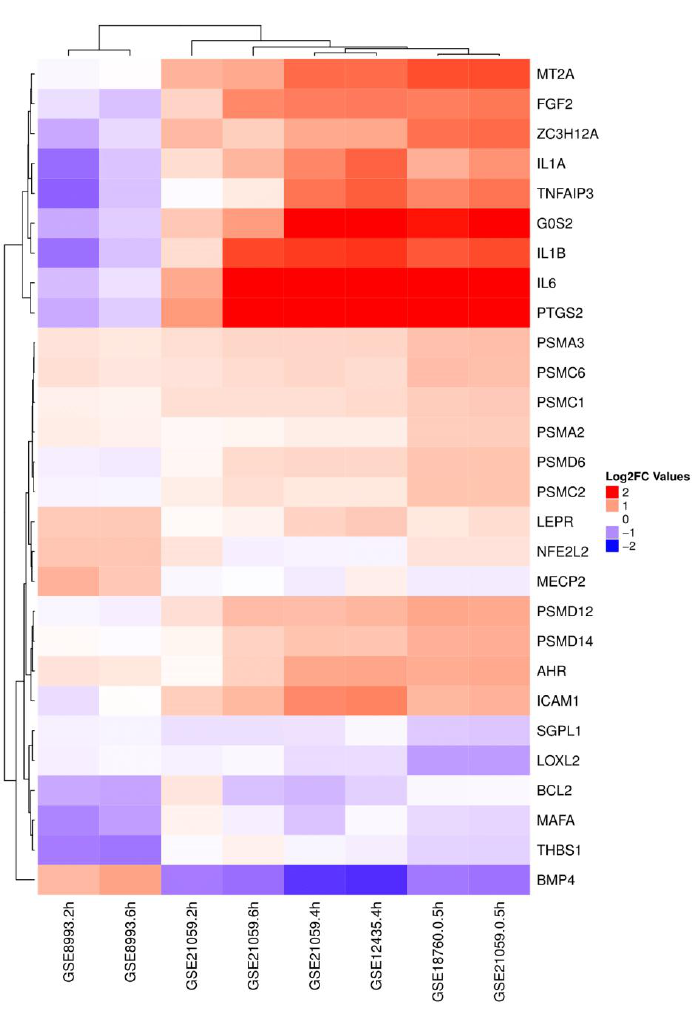
Figure 2. Heat map of the RIBE gene signature regarding the GSE12435*, GSE18760*, GSE21059*, and GSE8993 + datasets for the comparisons of bystander vs. control samples (GSEs with an asterisk highlight α -particles IR whereas the one marked with the plus symbol underlines carbon-ion IR). The relative Log2FC samples are represented in a ternary color format with red signifying: upregulation, blue: down regulation, and white: no alteration of gene expression regarding the